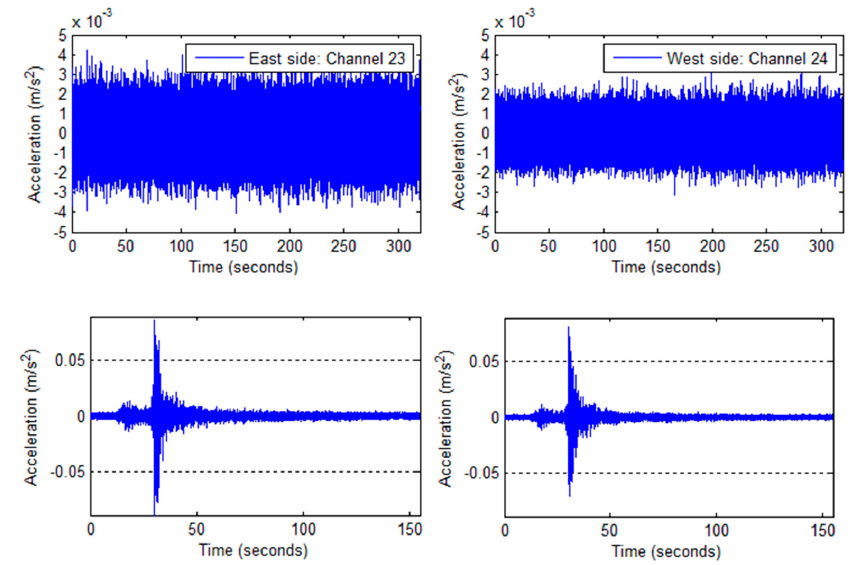
Figure 17. Accelerations from ambient vibrations ( Top ) and the Hollis Center earthquake ( Bottom ) at floor 12. Recordings from NS oriented accelerometers on the East side ( Left ) and West side ( Right ). Sensors 2016 , 16 , 1016